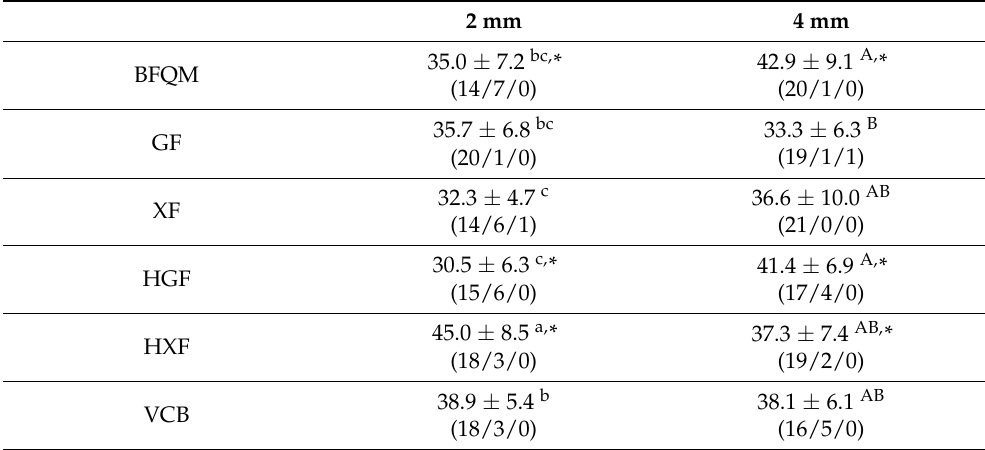
Table 2. Means ± standard deviations in MPa (fracture modes specimen’s numbers) for the effect of CAD/CAM thickness and resin composite type on the µ TBS.